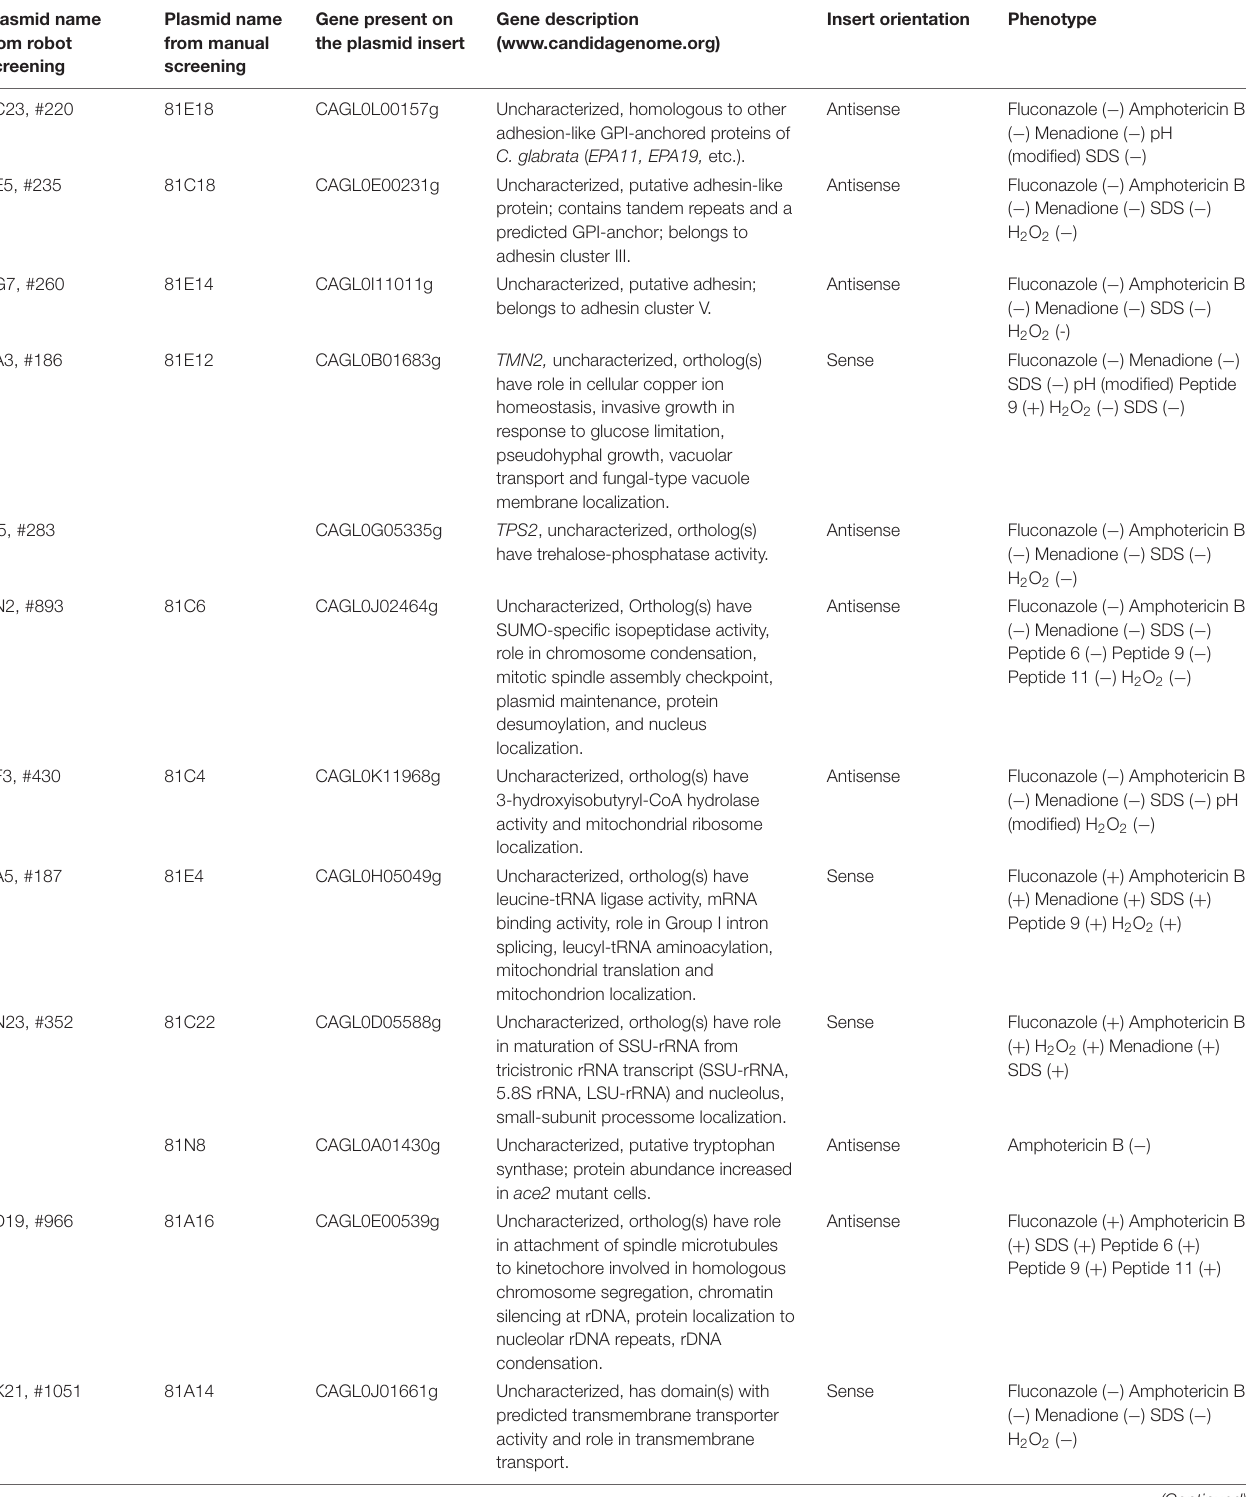
Plasmid name from